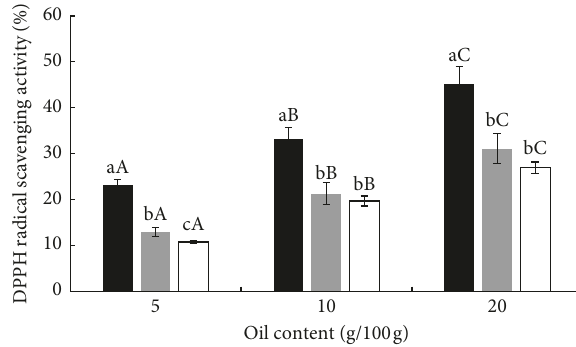
Figure 3: DPPH radical scavenging activity of the emulsions with different oil contents and emulsifiers ( SPI, SC, and SE). Different lowercase letters above bars indicate significant differ- ences among samples of different emulsifiers, and different up- percase letters above bars indicate significant differences among samples of different oil contents ( p < 0 .